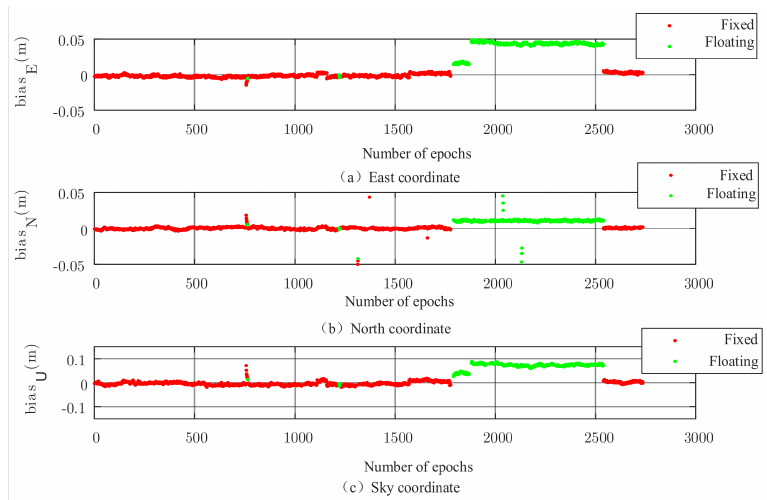
Figure 8. 3D baseline results of conventional PAR